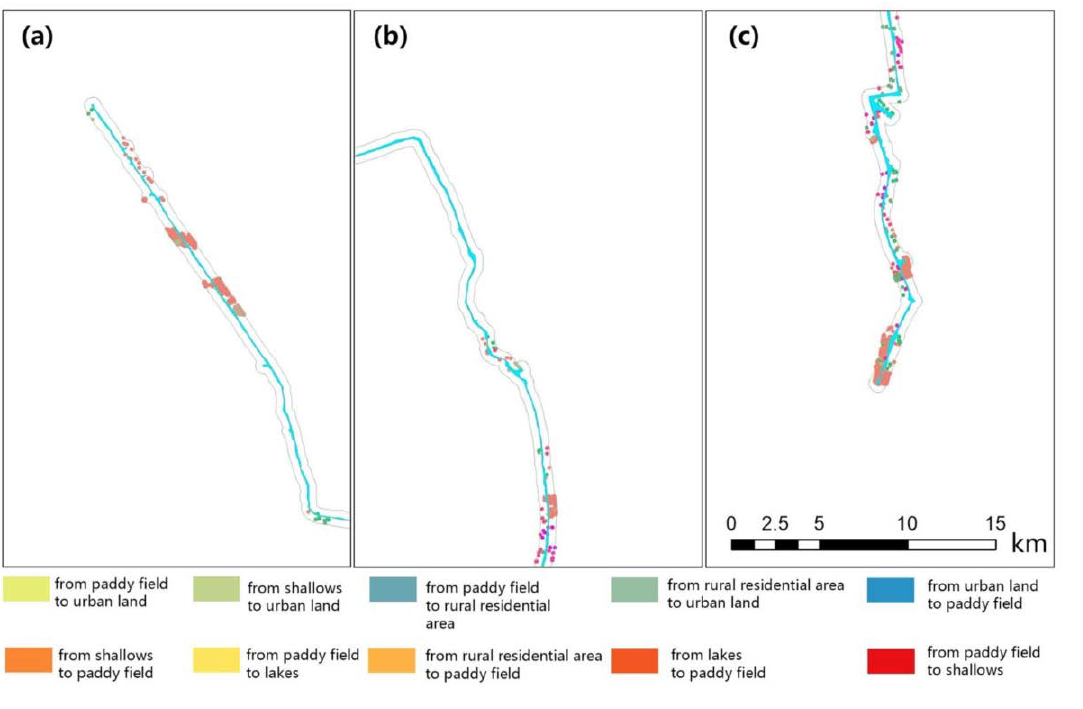
Figure 6. Changes of land use in the Suzhou section of the Grand Canal between 2010 and 2018. ( a ): Land type change in the upper reaches of the Grand Canal (Suzhou section), ( b ): Land type change in the middle reaches of the Grand Canal (Suzhou section), ( c ): Land type change in the downstream reaches of the Grand Canal (Suzhou section).